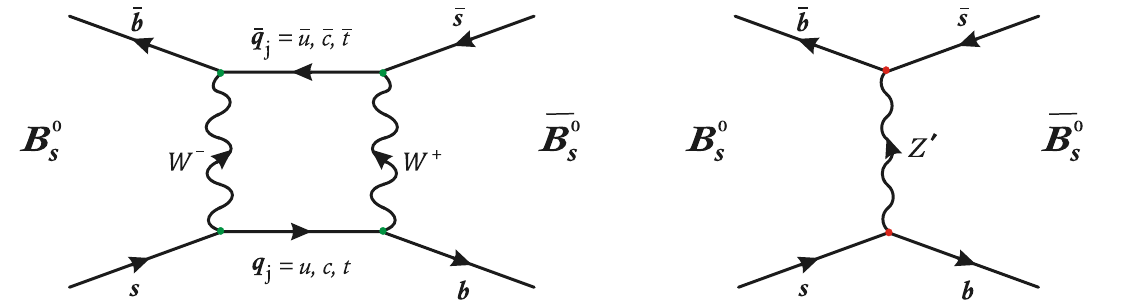
¯ B 0 s ) mixing in the SM. Right figure: Tree level contribution in models with